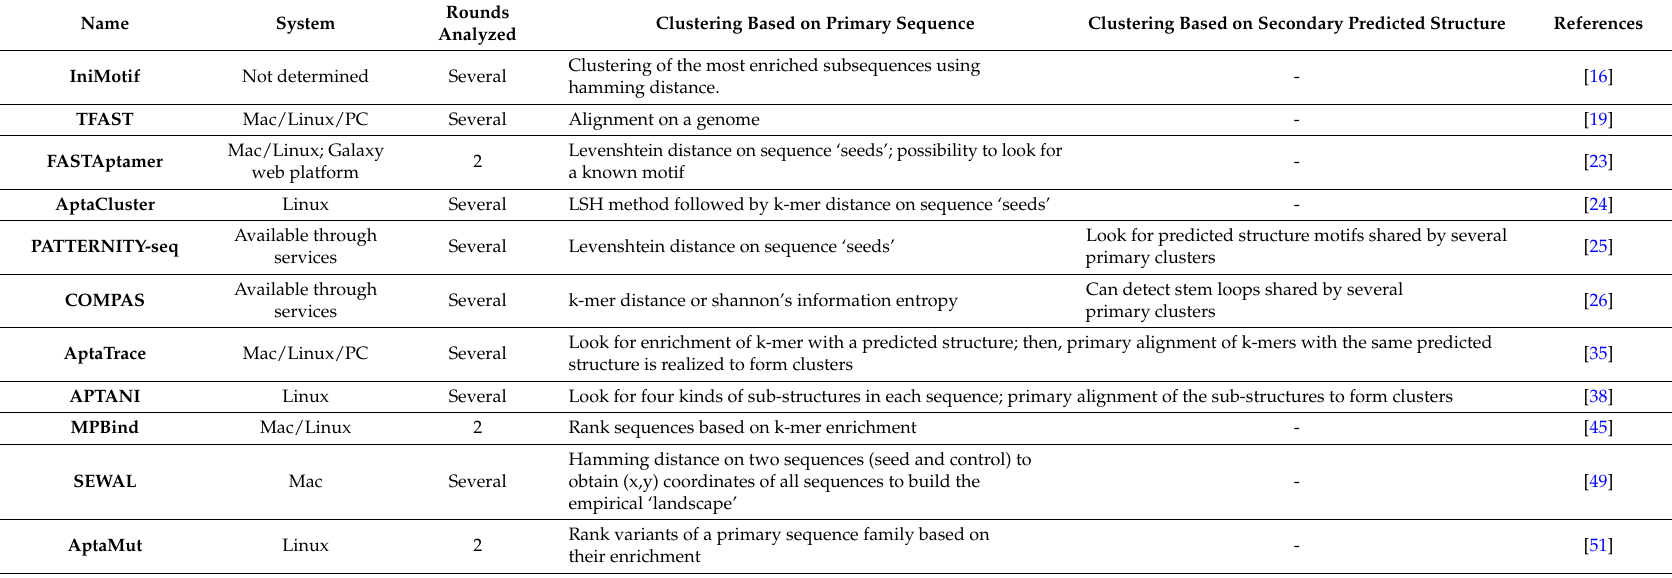
Table 1. Comparison of several programs dedicated to HTS analysis for SELEX